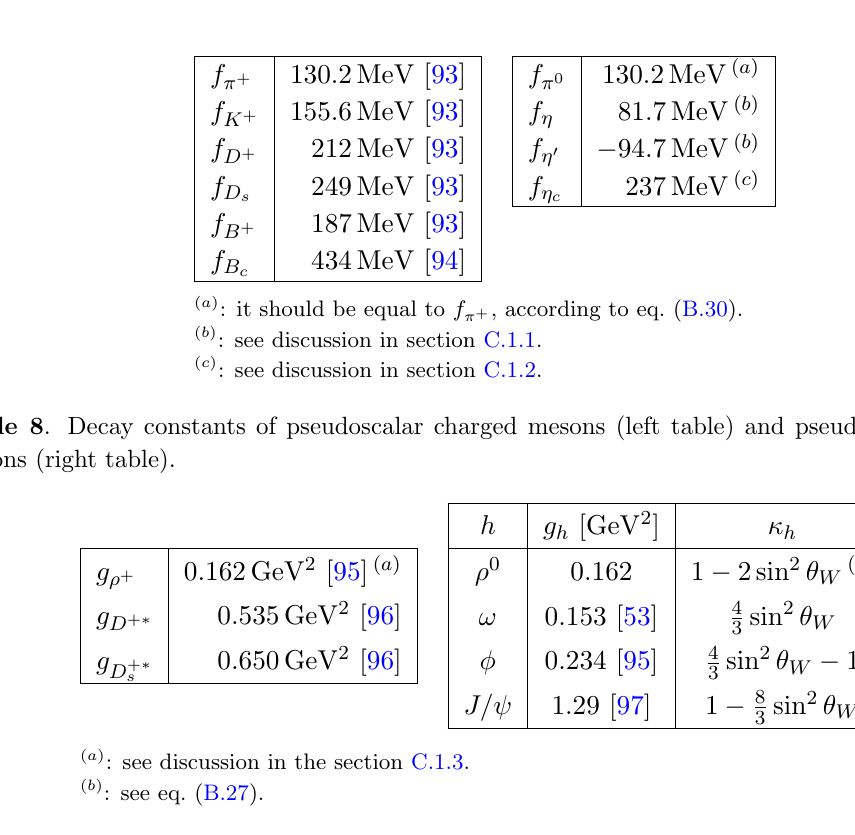
Table 9 . Decay constants of vector charged mesons (left table) and vector neutral mesons (right table). Decay constants for D (cid:3) mesons in [96] show large theoretical uncertainty, we quote only ( s ) the average value